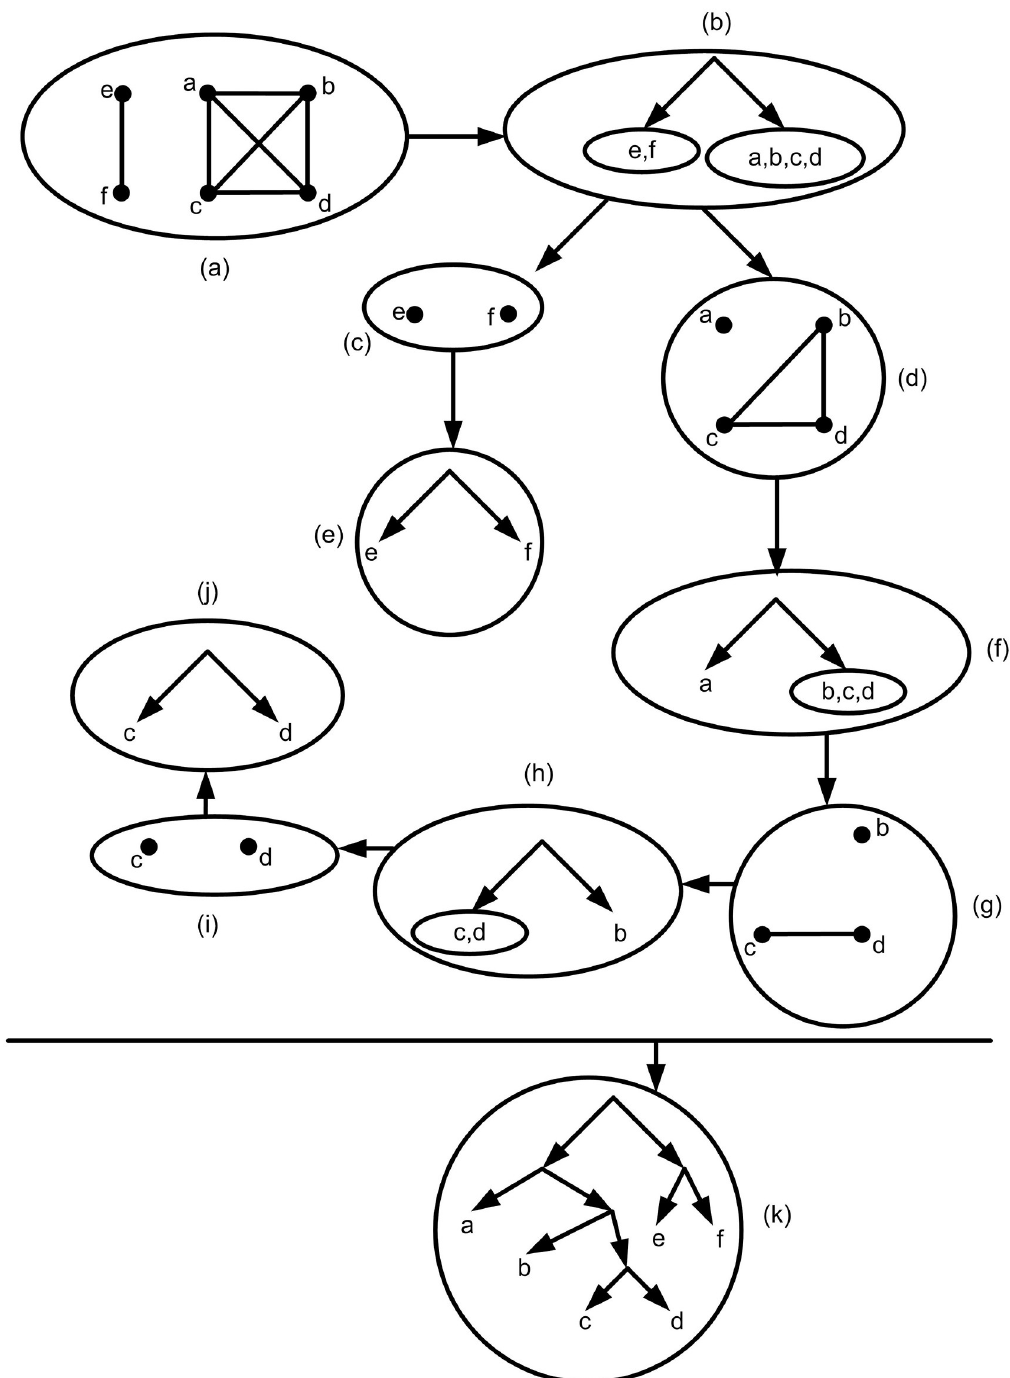
Fig 5. The Aho graph AG ( τ ) is defined based on τ . The set of nodes are X = L ( τ ) = { a , b , c , d , e , f } and two nodes i , j 2 X are adjacent iff there is a node x 2 X such that ij | x 2 τ . Also AG ( τ | A ) in which A � X is defined in a similar way. Note that in this way the induced graph of AG ( τ ) on the set of nodes A � X is considered i.e. the set of nodes are A and i , j 2 A are adjacent iff there is a node x 2 A such that ij | x 2 τ . (a) AG ( τ ). (b) Based on AG ( τ ) the resulting tree is obtained. (c) AG ( τ | e , f ). (d) AG ( τ | a , b , c , d ). (e) Based on AG ( τ | e , f ) the resulting tree is obtained. (f) Based on AG ( τ | a , b , c , d ) the resulting tree is obtained. (g) AG ( τ | b , c , d ). (h) Based on AG ( τ | b , c , d ) the resulting tree is obtained. (i) AG ( τ | c , d ). (j) Based on AG ( τ | c , d ) the resulting tree is obtained. (k) The final tree consistent with given τ that is obtained from BUILD algorithm by reversing its steps.